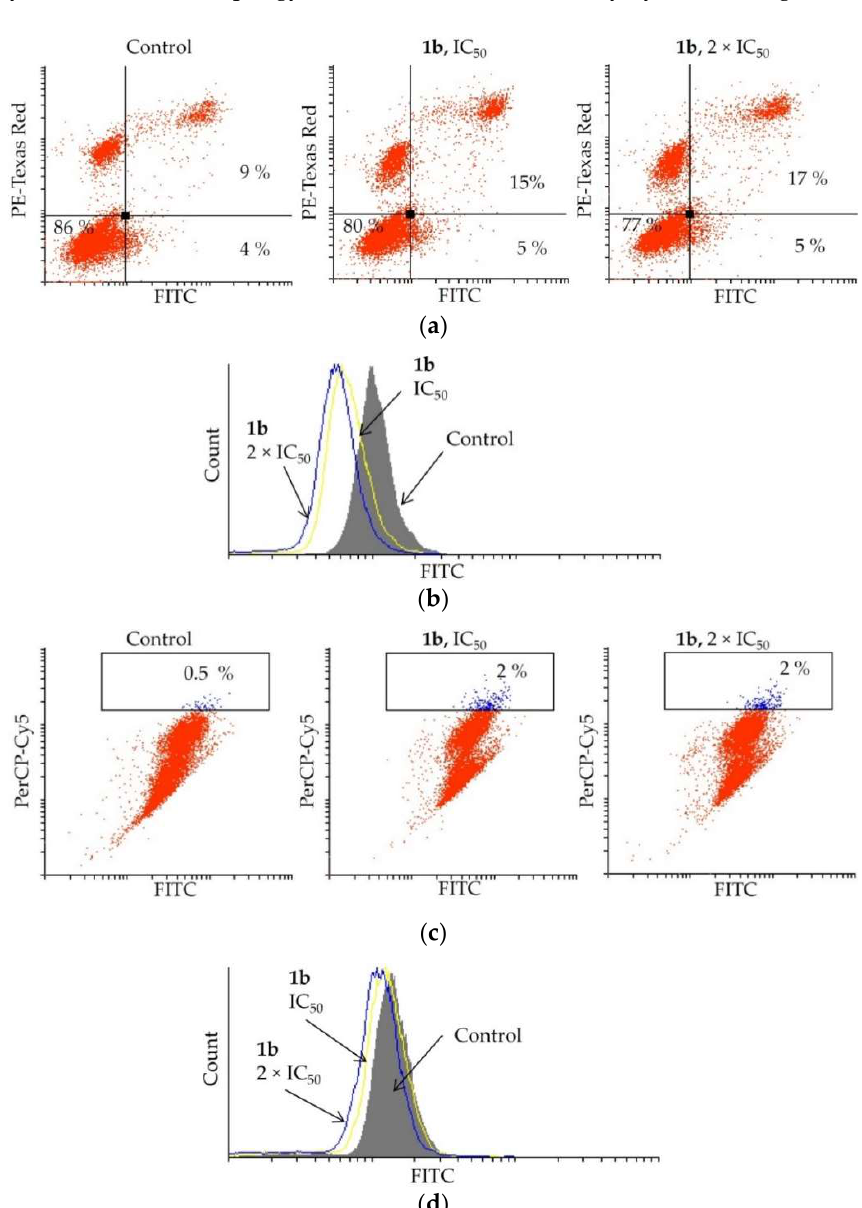
Figure 5. Effect of dendrimer 1b upon treatment of PC-3 cells with IC 50 and 2 × IC 50 concentrations (72 h) on ( a ) induction of apoptosis, ( b ) caspase production, ( c) induction of autophagy, and ( d ) NO production.